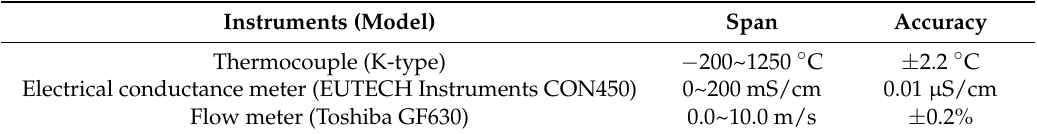
( d ) Figure 18. Liquid film thickness with different temperature conditions: ( a ) 20  C; ( b ) 30  C; ( c ) 40  C; and ( d ) standard deviation 4. Conclusions In order to confirm the feasibility of the three-electrode conductance method for liquid film thickness measurements, which is expected to be advantageous under varying temperature conditions, two prototype liquid film sensors were fabricated on an FPCB. The designs of the prototypic sensors were determined by electrical potential analyses. The calibration tests of these sensors showed that the fabricated sensors are applicable in conditions with mild temperature variances at temperatures lower than 20  C. Subsequently, the liquid film sensor was applied to a